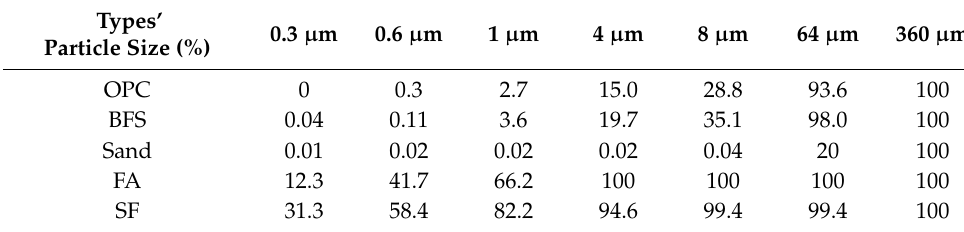
Table 1. Particle passing percentage of raw materials (%).